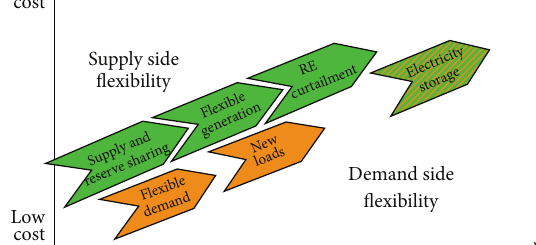
Figure 4: Ragone plot.